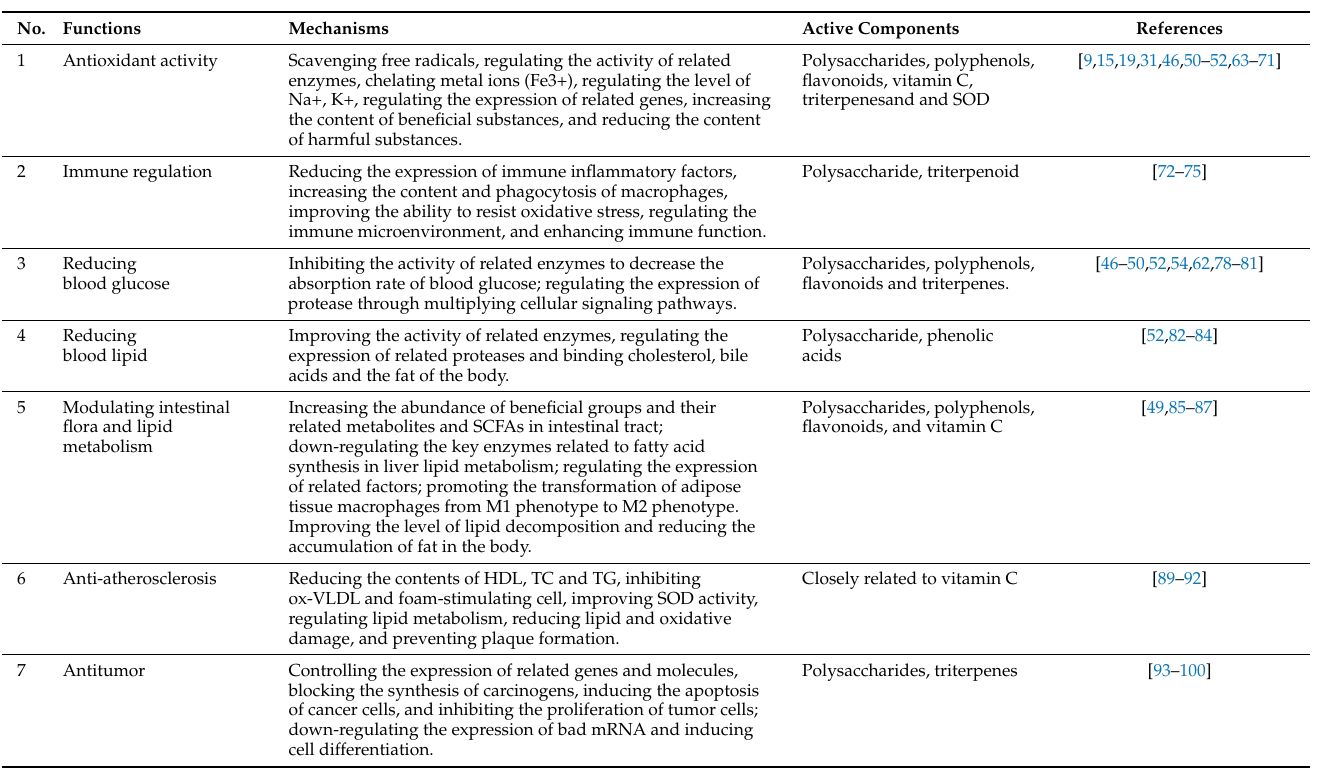
Table 7. Pharmacological activities of R. roxburghii and their related mechanisms and active compo-